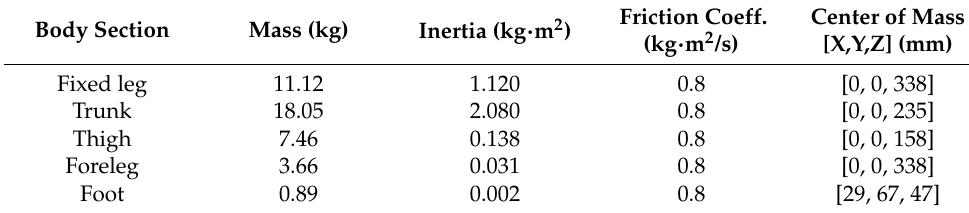
Figure 5. Model validation tests. Table 2. Physical body-exoskeleton design